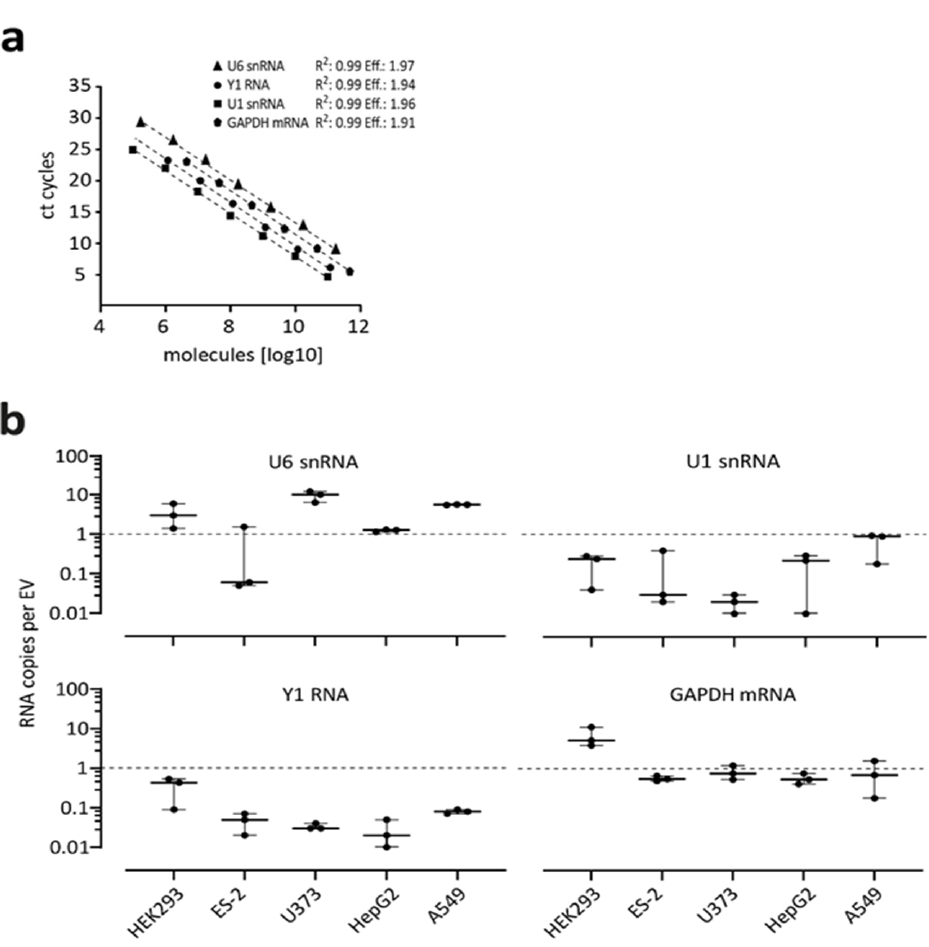
Figure 3. Absolute quantification of endogenous RNAs in EVs: U6 snRNA, Y1 RNA, U1 snRNA, and GAPDH mRNA. ( a , b ) Absolute quantification of copy numbers per EV for four different RNAs. For standard curves with equations and amplification efficiencies used for absolute quantification by RT-qPCR, see panel a . EVs were purified from five different cell lines (HEK293, ES-2, U373, HepG2, and A549), followed by RT-qPCR assays (panel b ; copy numbers per EV in log10-scale; n = 3, with mean and standard deviations).